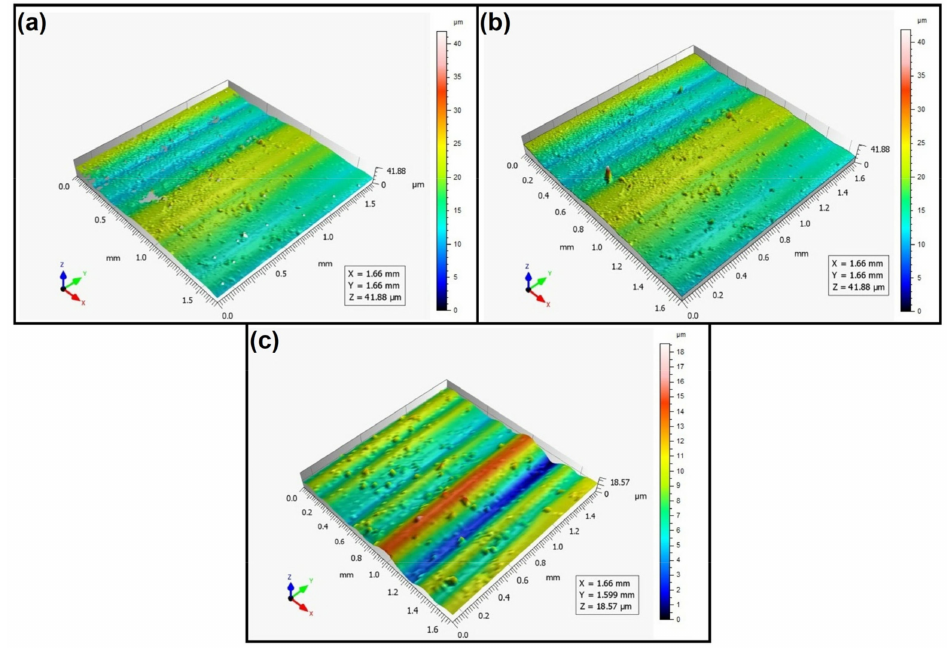
Figure 9. Surface topography of the element 3D printed using PJM technology (Pd = 0 ◦ ). ( a ) Talysurf CCI—without filling non-measured points, ( b ) Talysurf CCI—after filling non-measured points, ( c ) Talysurf PGI